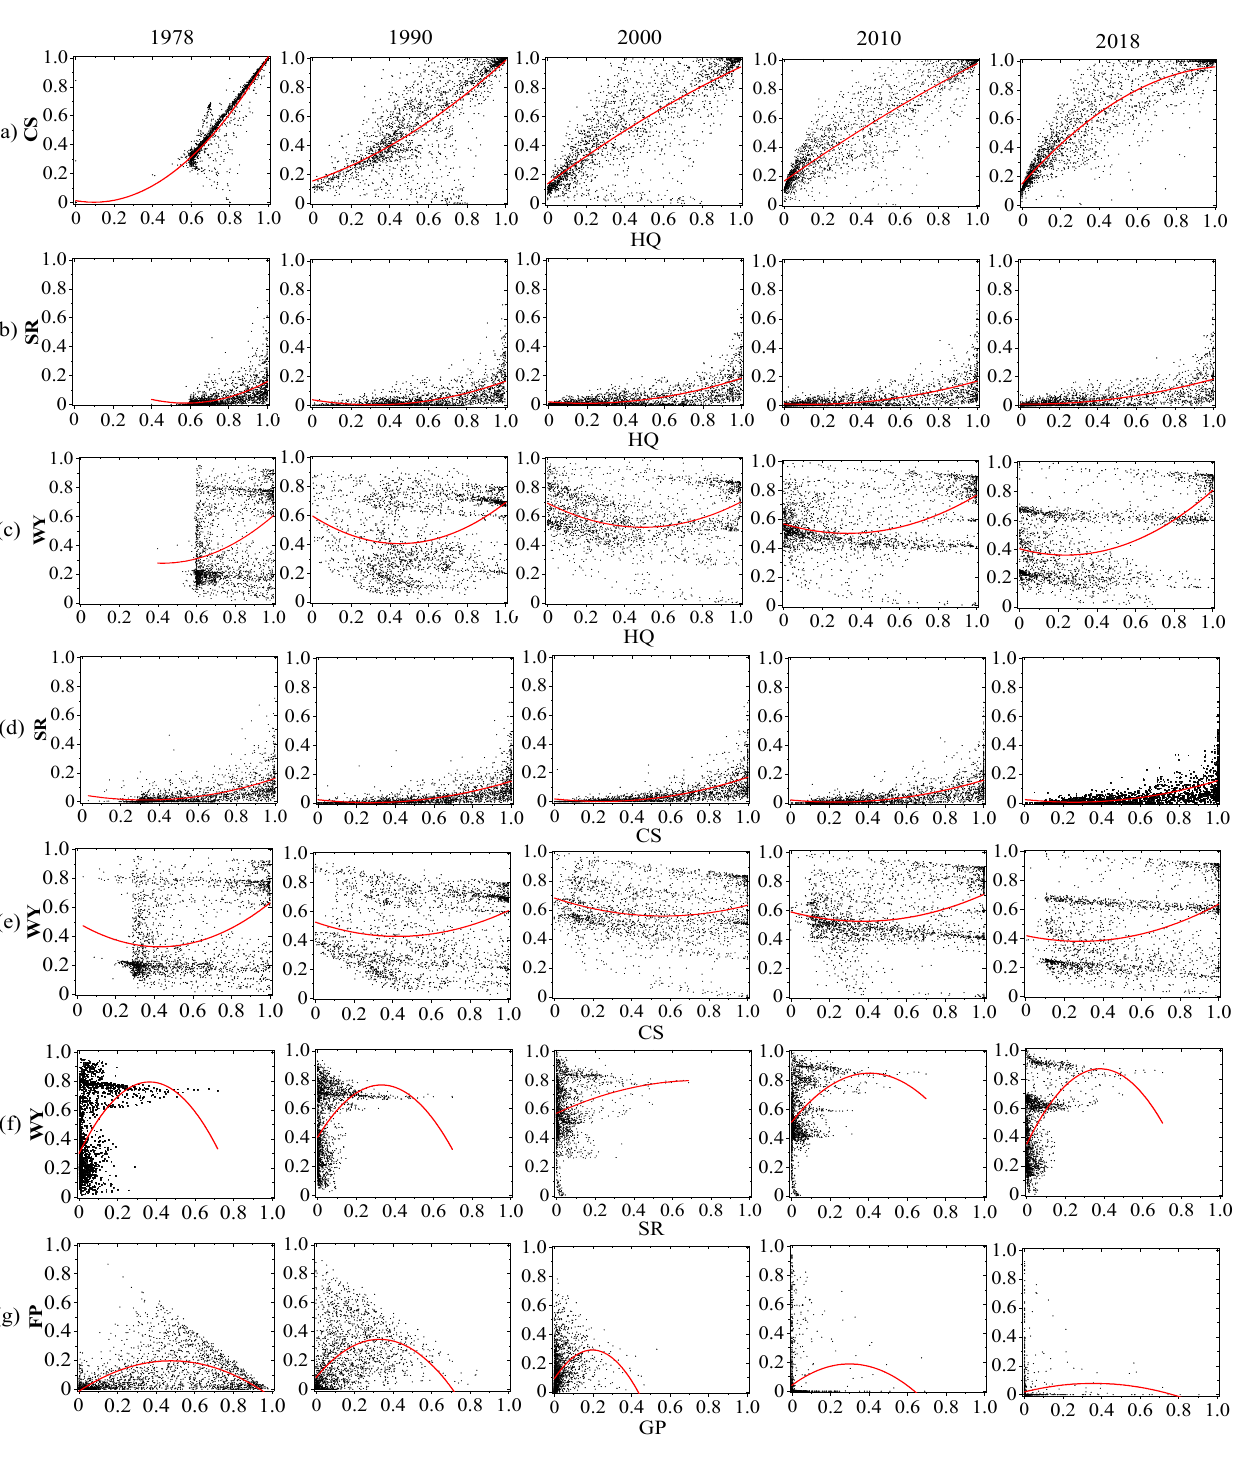
Figure 6. The synergy evolution of typical ESs during 1978–2018. Ecosystem service pair for ( a ) HQ–CS; ( b ) HQ–SR; ( c ) HQ–WY; ( d ) CS–SR; ( e ) CS–WY; ( f ) SR–WY; ( g ) GP–FP. Plots in the same row represent different